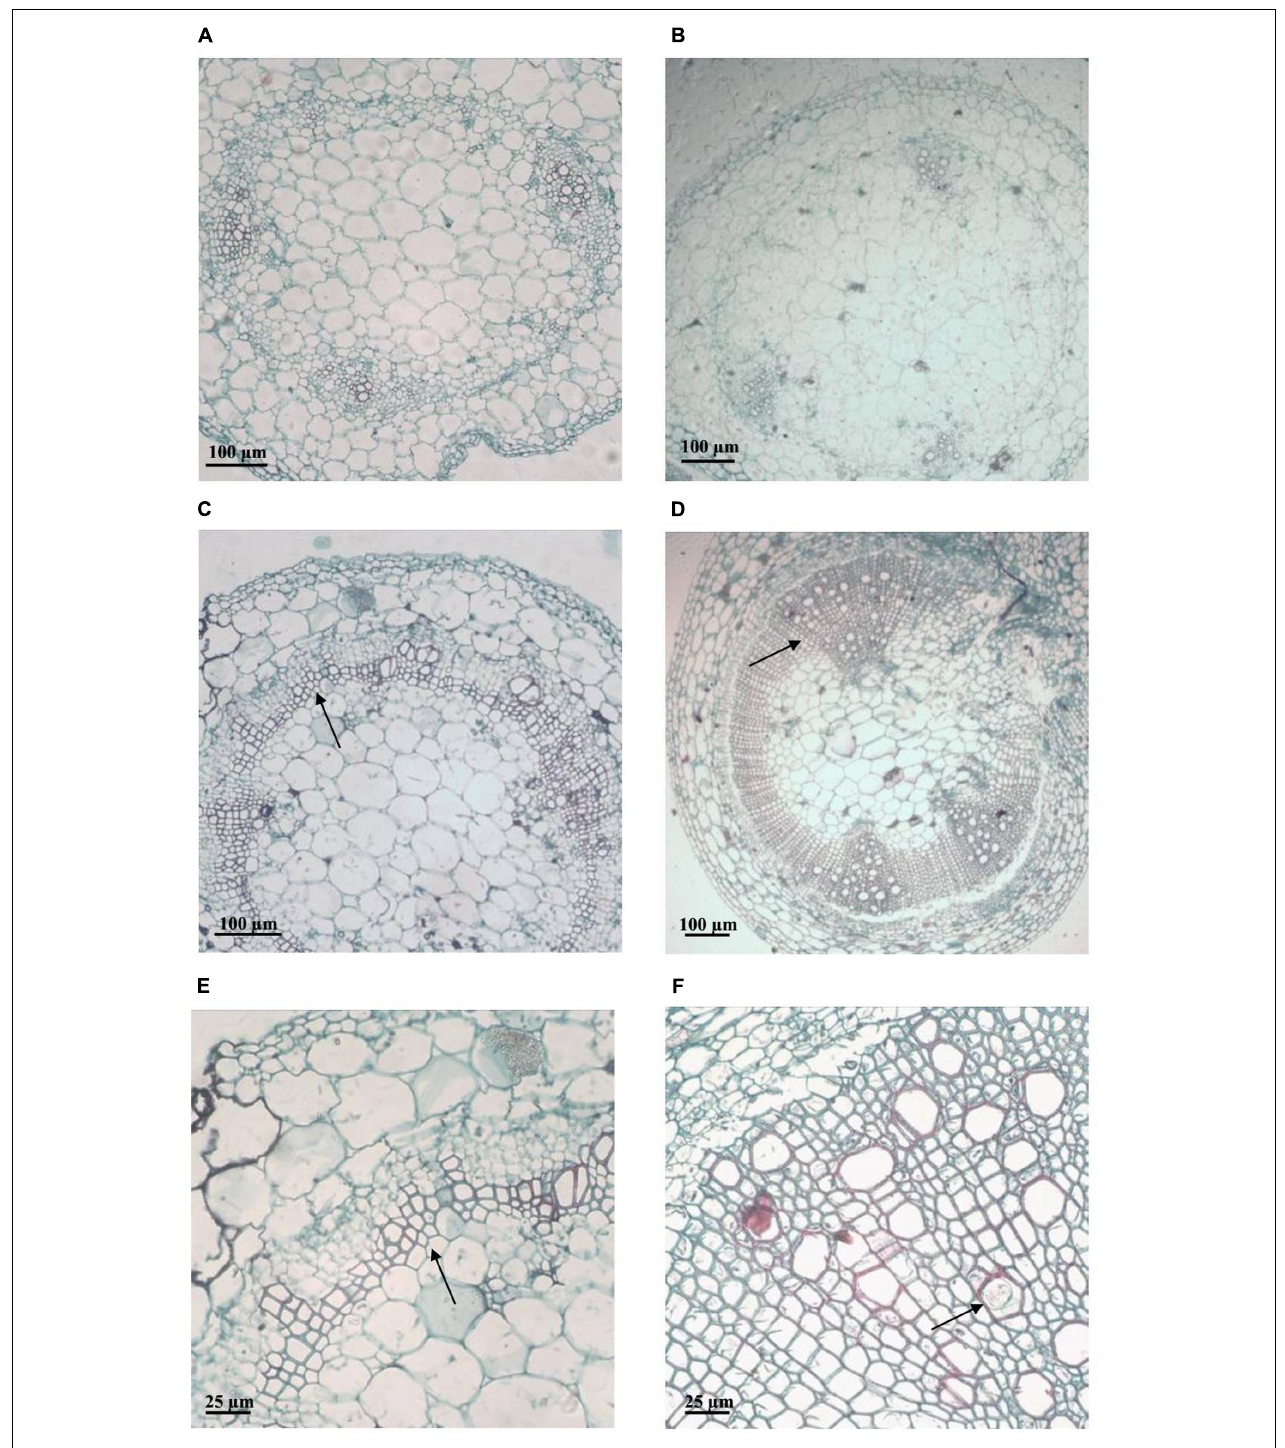
FIGURE 6 | Representative light micrographs of safranin-fast green stained stem cross-sections of plants from the susceptible potato cultivar S. tuberosum cv. Chieftain and the tolerant clone 09509.6. Xylem vessels architecture was evaluated 5 days after soil inoculation with R. solanacearum UY031 strain and compared to mock inoculated plants. Safranin dyes secondary cell walls red and fast green dyes cellulose light blue. (A) Mock inoculated Chieftain plant. (B) Mock inoculated 09509.6 plant. (C,E) Chieftain plant inoculated with R. solanacearum . (D,F) 09509.6 plant inoculated with R. solanacearum . Dark arrows show hyperplasic activity and lignin deposition (C–E) , or xylem vessels occluded by tyloses with globular shape (F) .